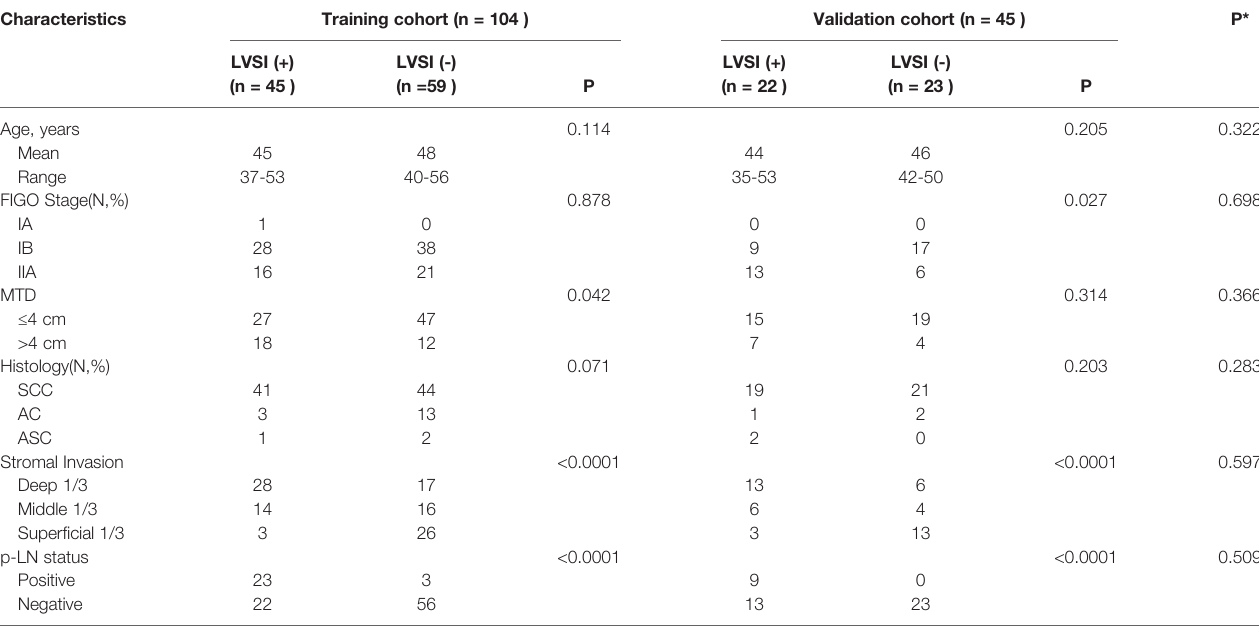
TABLE 2 | Characteristics of involved patients. Characteristics